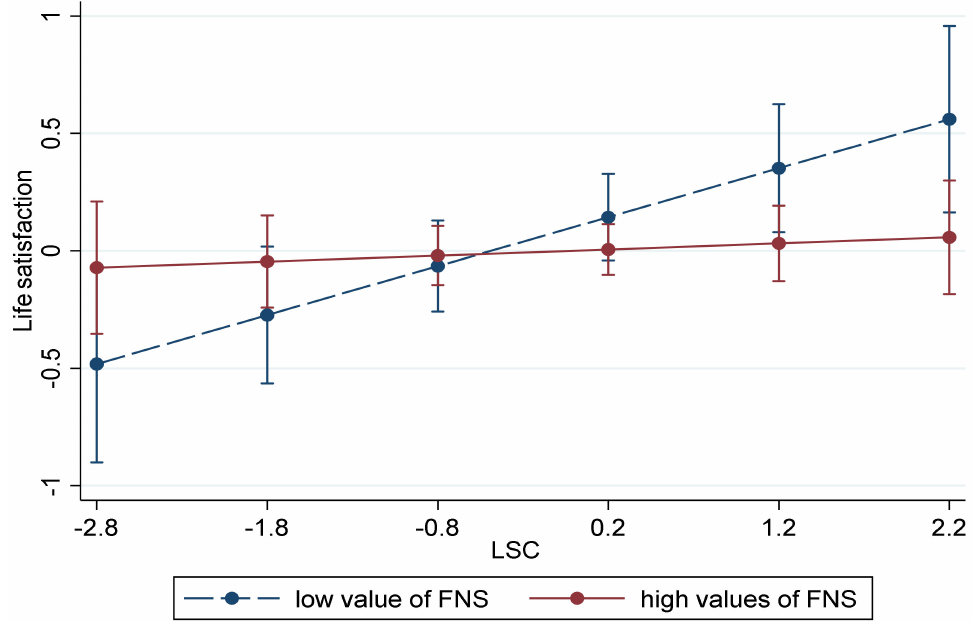
Figure 2. The association between linking social capital and life satisfaction with friendship network size as a moderator. Note: LSC = linking social capital, FNS = friendship network size.